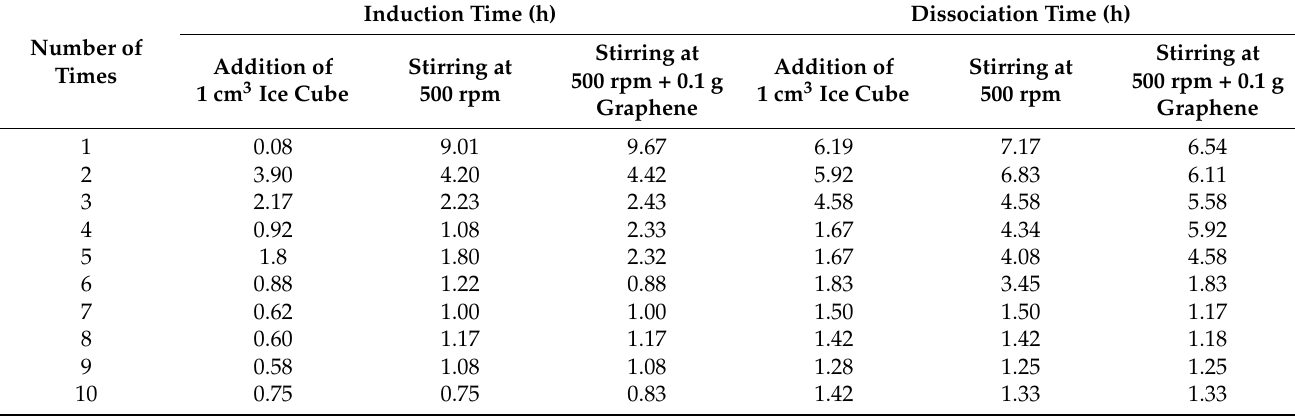
Table 4. Induction and dissociation times indicating the stability of the TBAB/TBAC hydrate in cyclic formation.